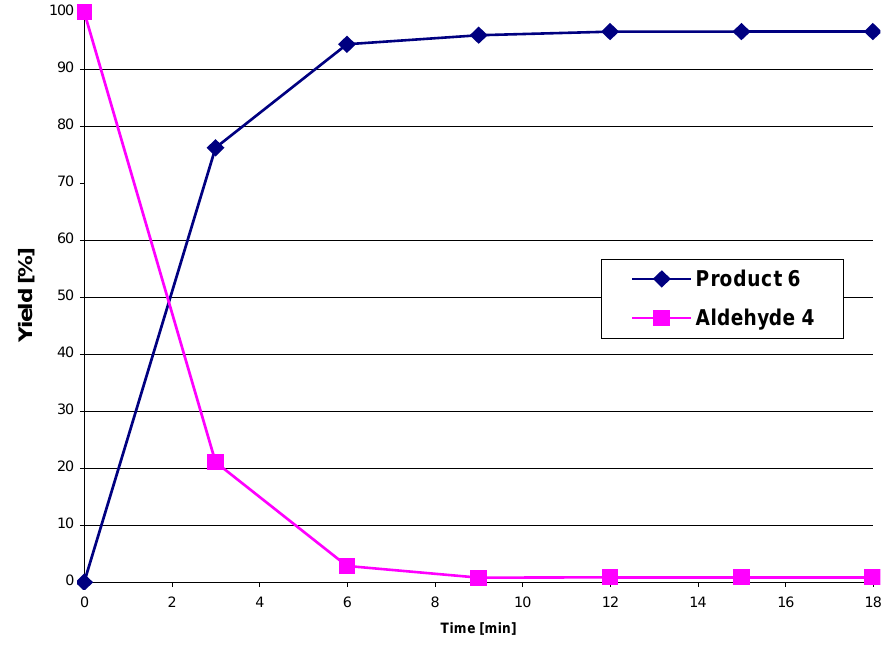
Figure 1 . Conversion of aldehyde 4 in the presence of amine 5a to the diastereomeric mixture 6 under microwave irradiation at 215